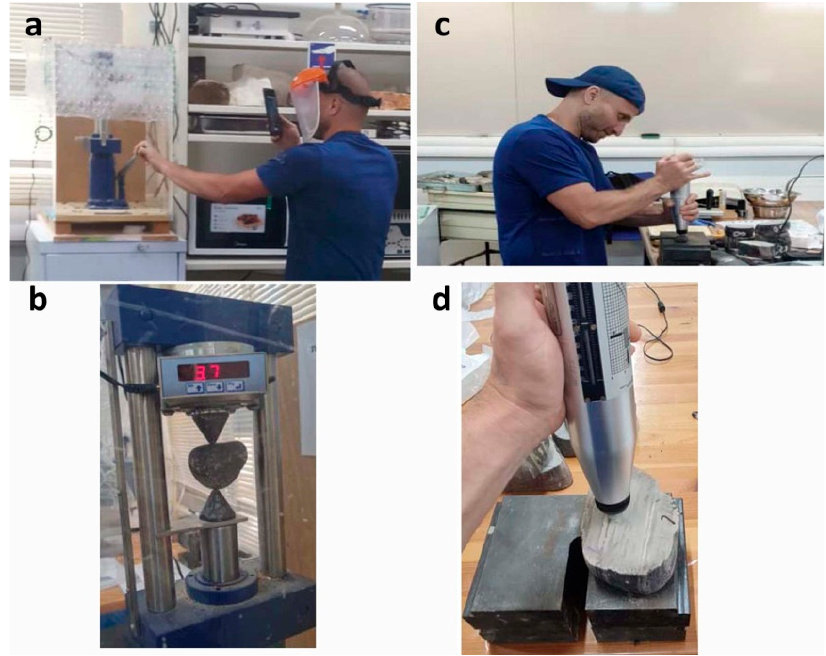
Figure 7. ( a ) The utilization of the Point Load test; ( b ) zoom-in of the Point Load instrument and the chert sample; ( c ) the use of the Schmidt hammer; ( d ) zoom-in of the Schmidt hammer and the chert sample during the test.